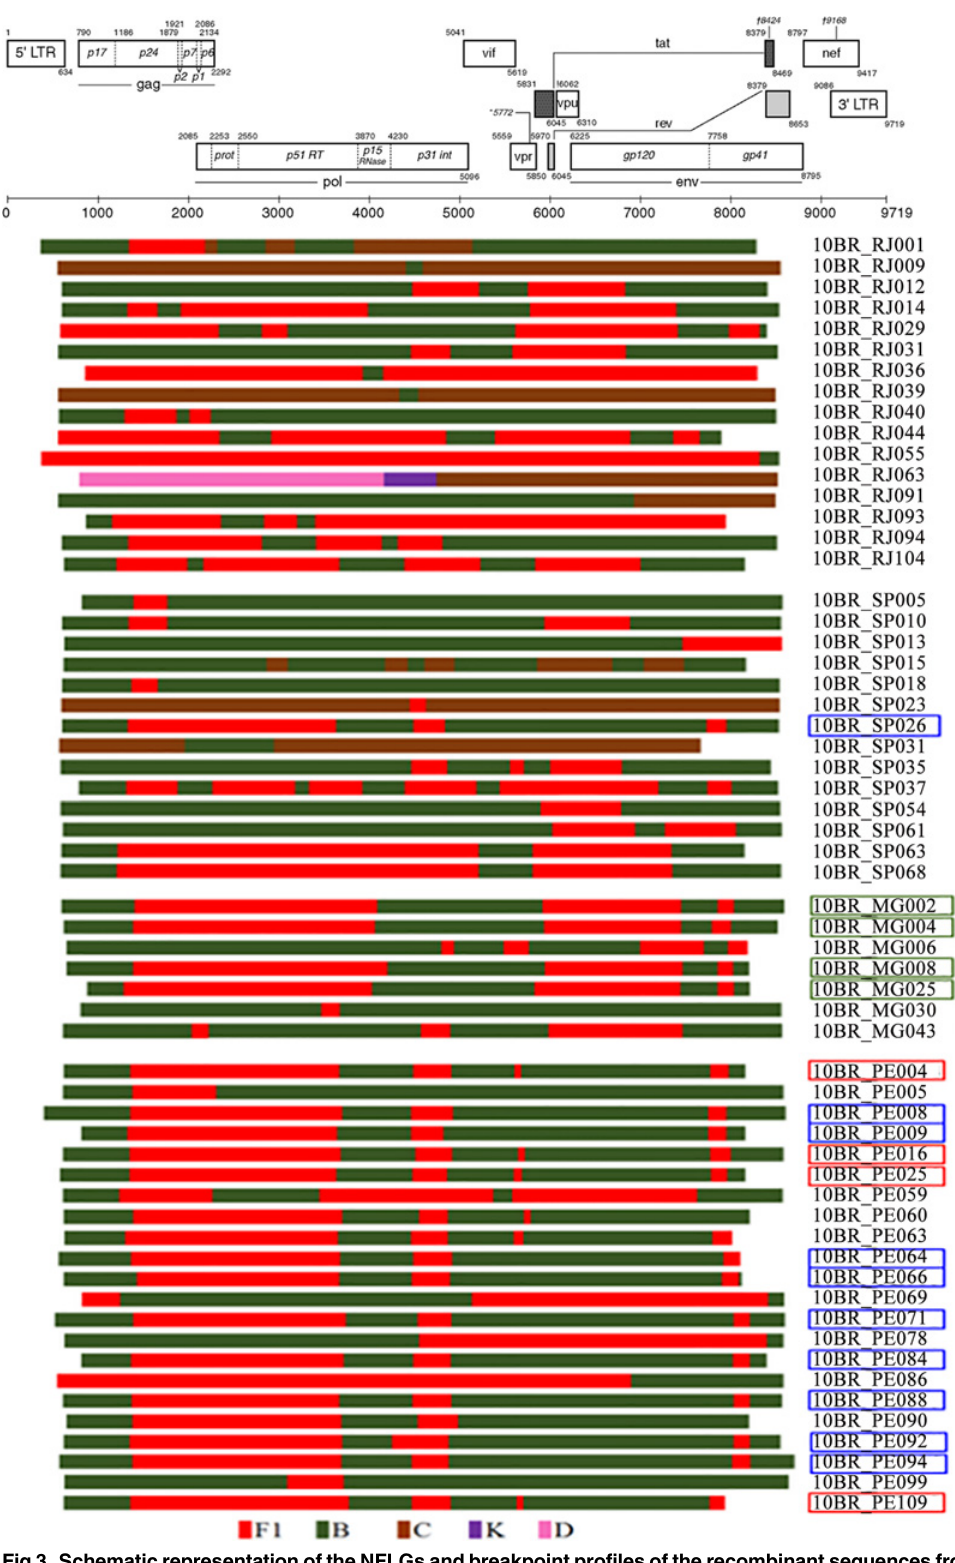
Fig 3. Schematic representation of the NFLGs and breakpoint profiles of the recombinant sequences from proviral DNA are generated by a deep sequencing approach identified in this study. Sequences were mapped relative to the HXB2 numbering system. HIV subtypes are color codes and